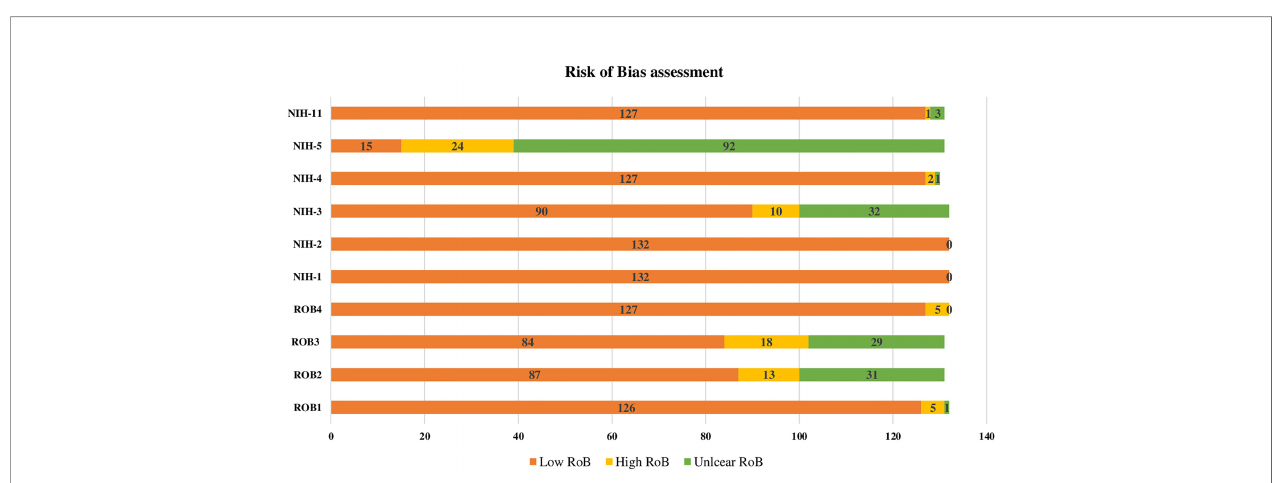
FIGURE 2 | Risk of Bias assesment of the 132 reviewed research reports on GDM. RoB1: GDM ascertainment (1: biological assay/medical records; 2: self- reported; 3: unclear) RoB2: Sampling methodology (1: probability-based ''random, consecutive, or whole population within a speci fi ed period of time''; 2: